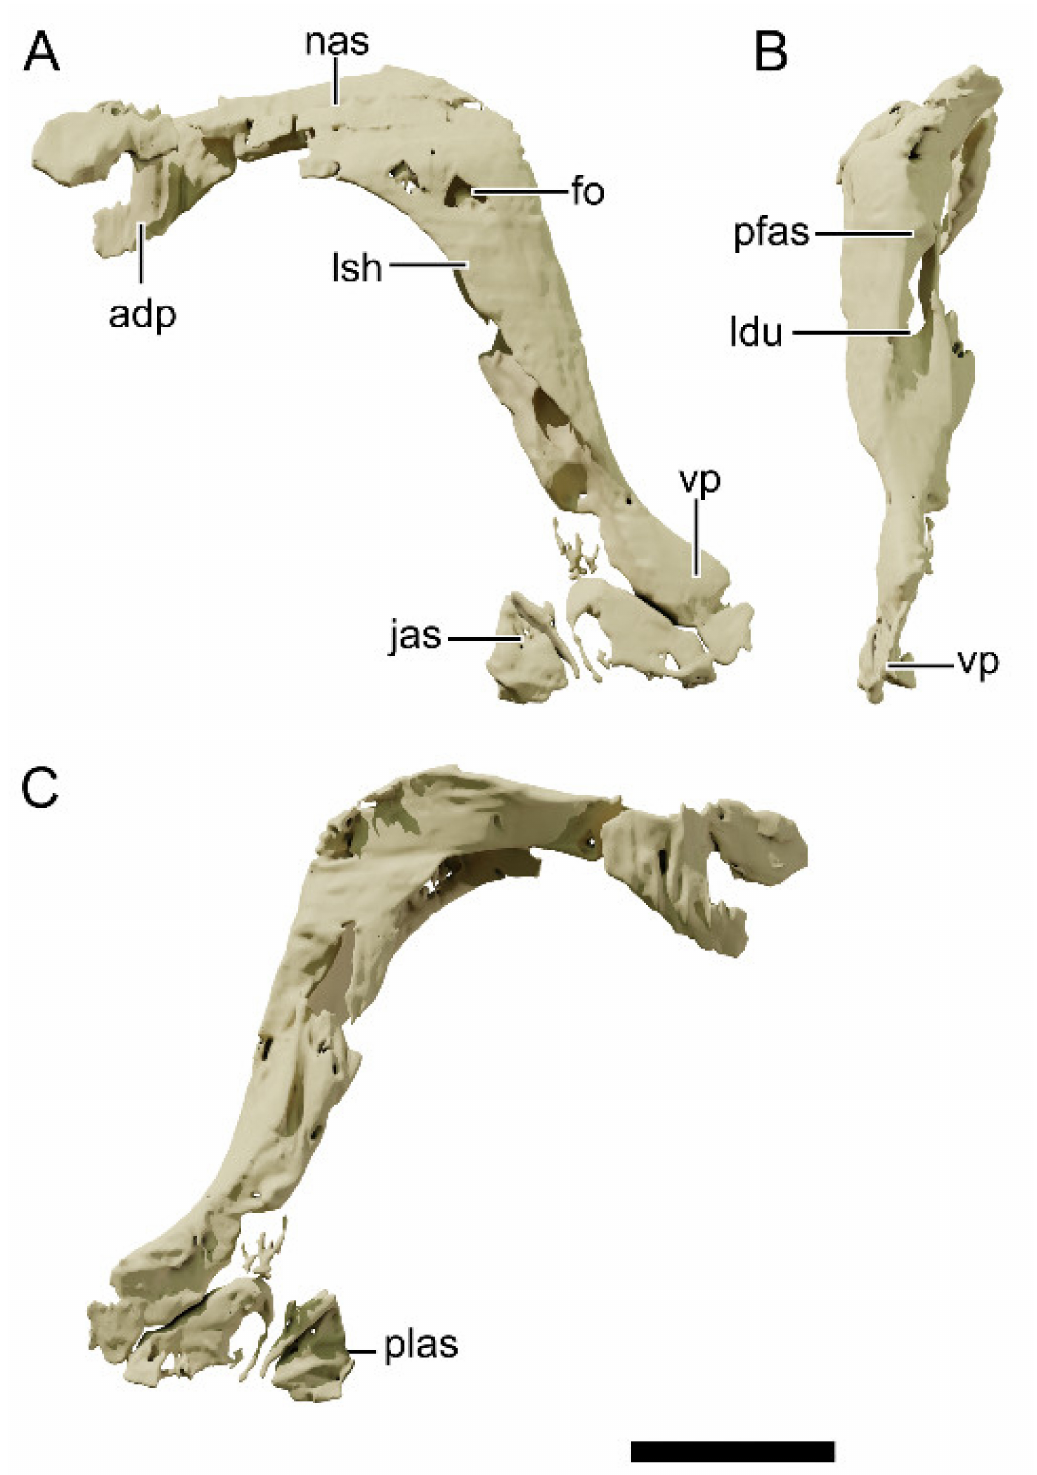
Figure 12. Digital reconstruction of the left lacrimal of NHMD 164741. ( A ) Lateral view. ( B ) Posterior view. ( C ) Medial view. Abbreviations: adp, anterodorsal process; fo, foramen; jas, articular surface for the jugal; ldu, lacrimal duct; lsh, lateral sheet of bone; nas, articular surface for the nasal; pfas, articular surface for the prefrontal; plas, articular surface for the palatine; vp, ventral process. Scale bar = 20